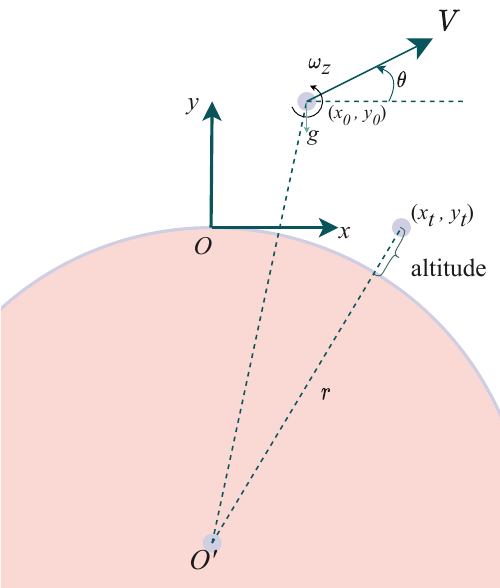
Figure 1. HSV motion